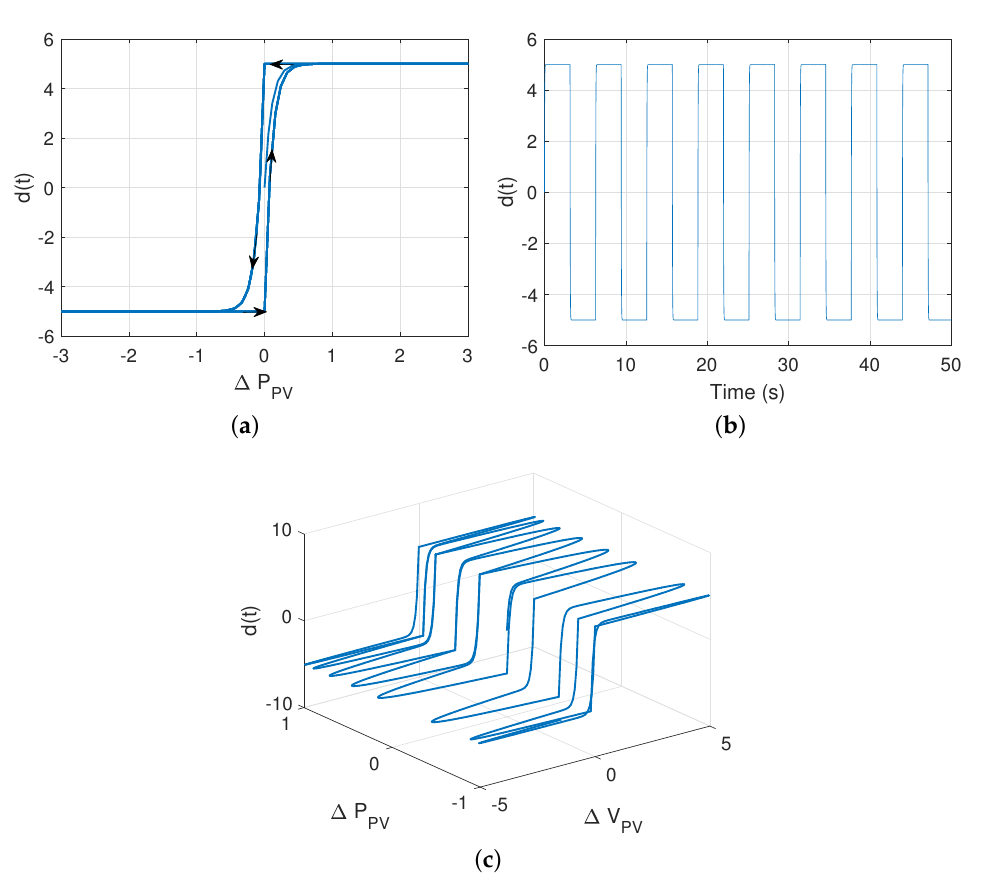
Figure 6. Hysteresis behavior of the system Equation (7). ( a ) hysteresis loop d ( t ) versus ∆ P PV ; ( b ) hysteresis system response d ( t ) ; ( c ) 3D hysteresis